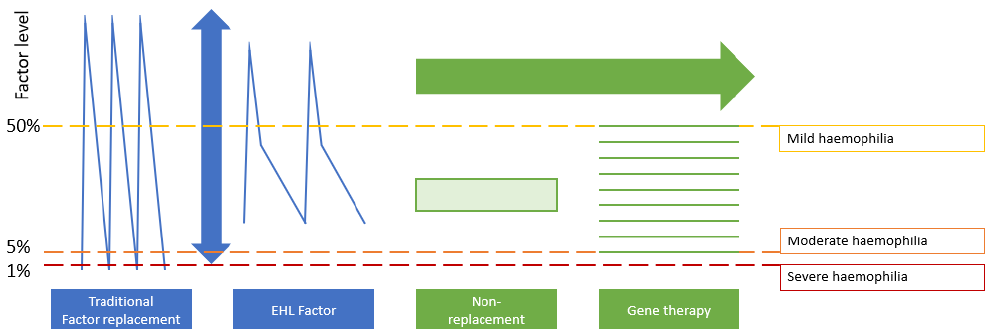
Figure 1. Key differences in haemostatic coverage with different pharmacological approaches for haemophilia [28]. Peak and trough patterns characteristic of traditional factor replacement and EHL factor are compared to the flat profiles of non-replacement and gene therapy. For gene therapy, the green lines represent nine theoretical patient profiles. These are shown to demonstrate the variation in levels that may be achieved, but that each person maintains a constant level over time. The figure is adapted and reproduced with permission from Elsevier Science and Technology Journals.